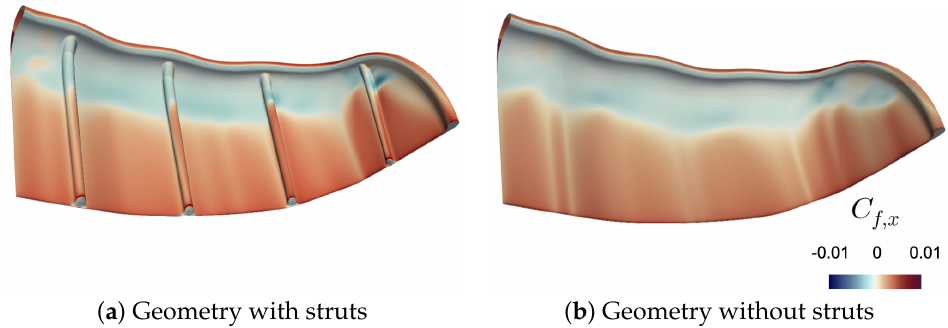
Figure 9. Contour plot of the streamwise component of the friction coefficient on the pressure side of the wing, for Re = 3 × 10 6 and α = 12 ◦ , taken from